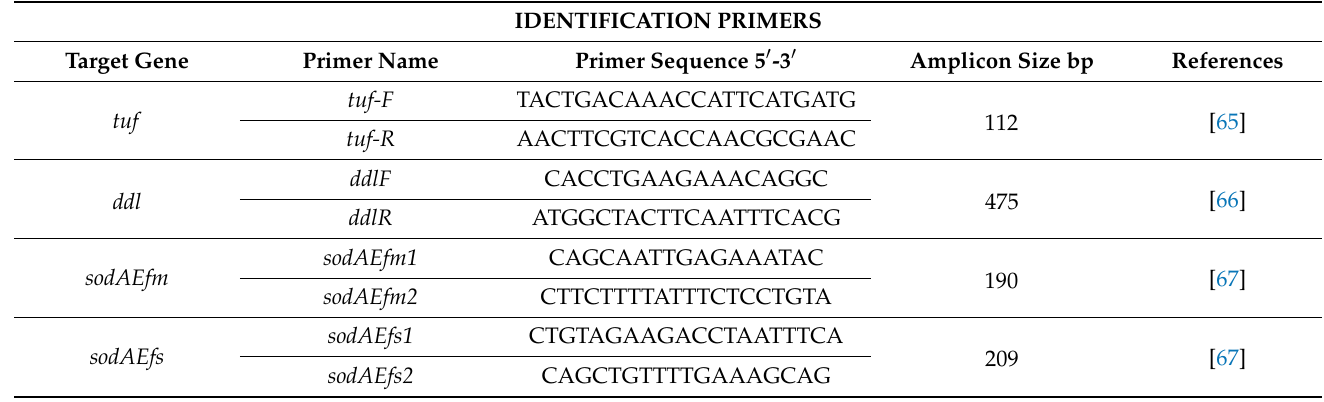
Table 9. Primers for Enterococcus Genus and Species